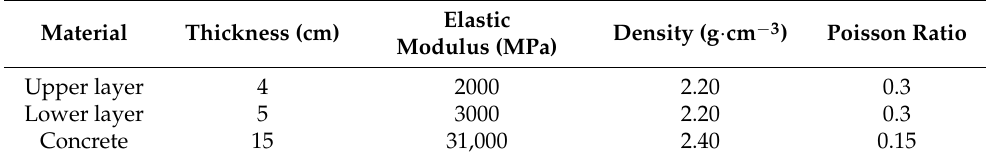
Figure 4. The meshing of 1/4 three-dimensional FE model. Table 1. Properties of bridge deck pavement layers.